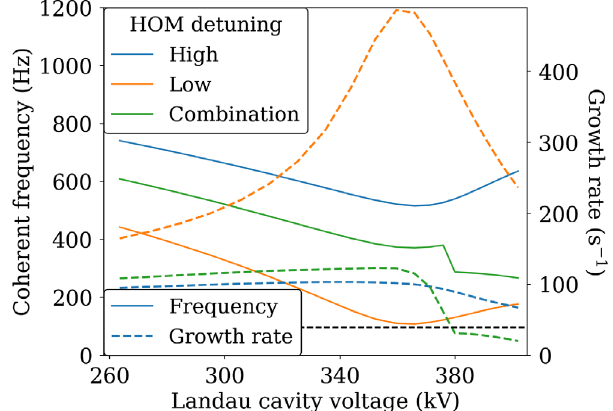
FIG. 9. Growth rates and coherent frequencies of coupled- bunch modes driven by two similar HOMs either detuned similarly or in opposite directions from the nearest revolution harmonic. The black dashed line shows the radiation damping rate of 40 s − 1